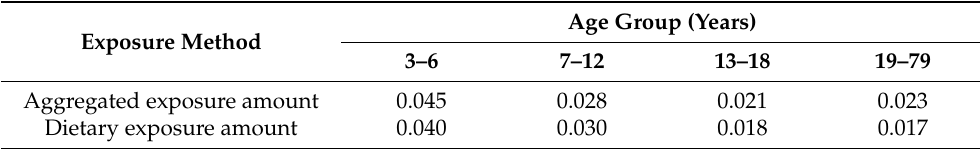
Table 2. Bisphenol A exposure assessment in Korean general population by age in 2018–2020 ( µ g/kg